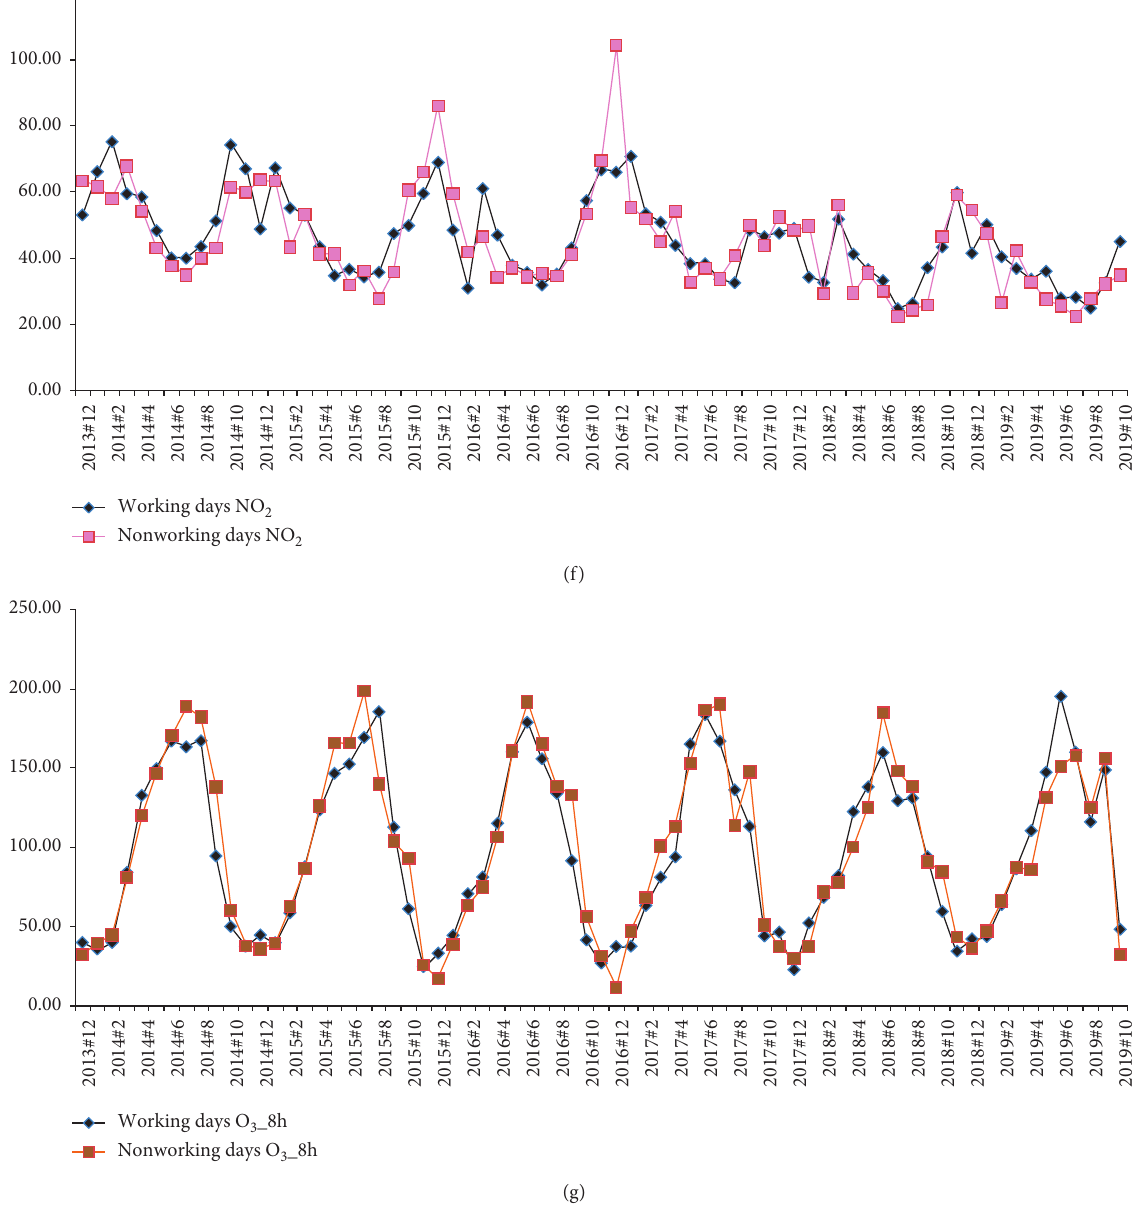
Figure 2: Comparison with working days and nonworking